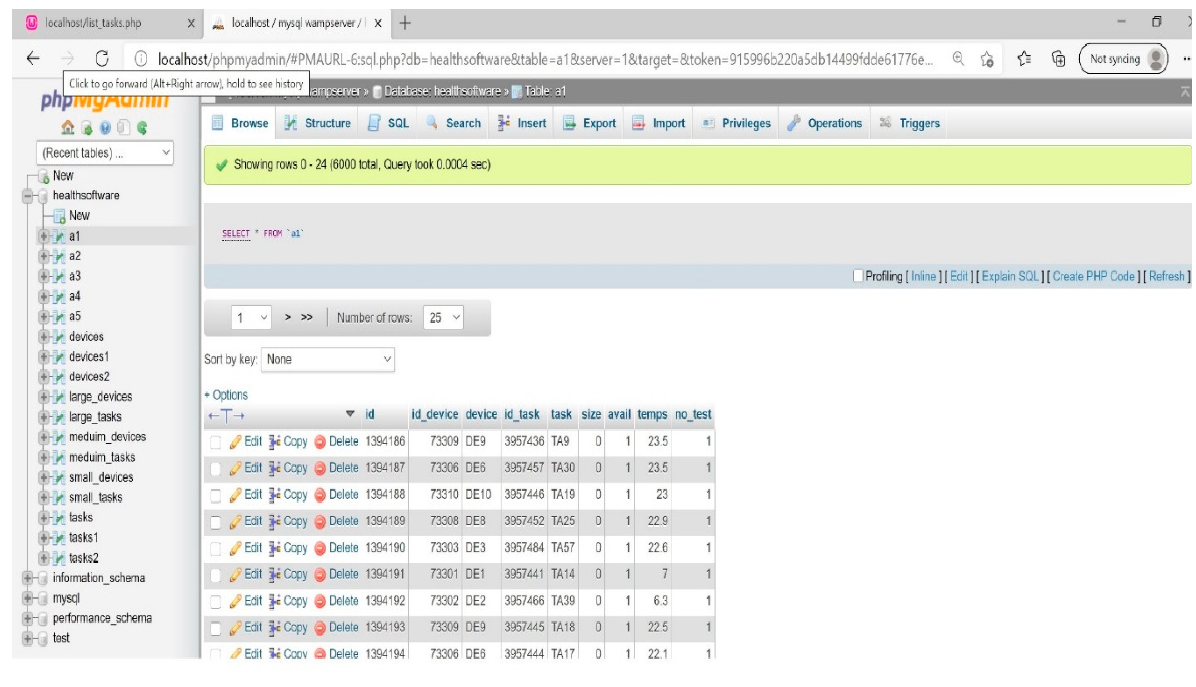
Figure 4. Four graphical user interfaces in the menu of the software application.